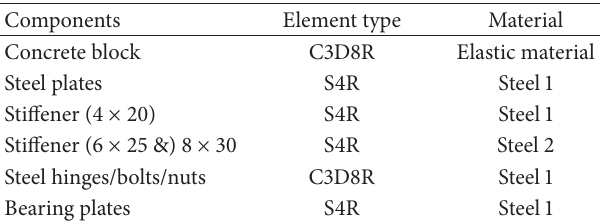
Table 2: The modelling of main